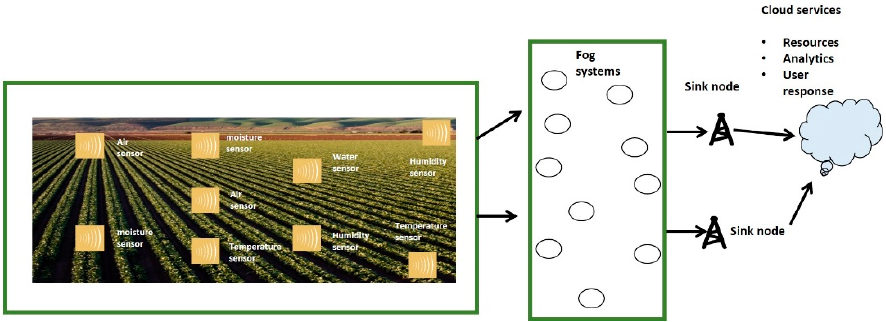
Figure 1. Scenario for fog-based IoT agricultural